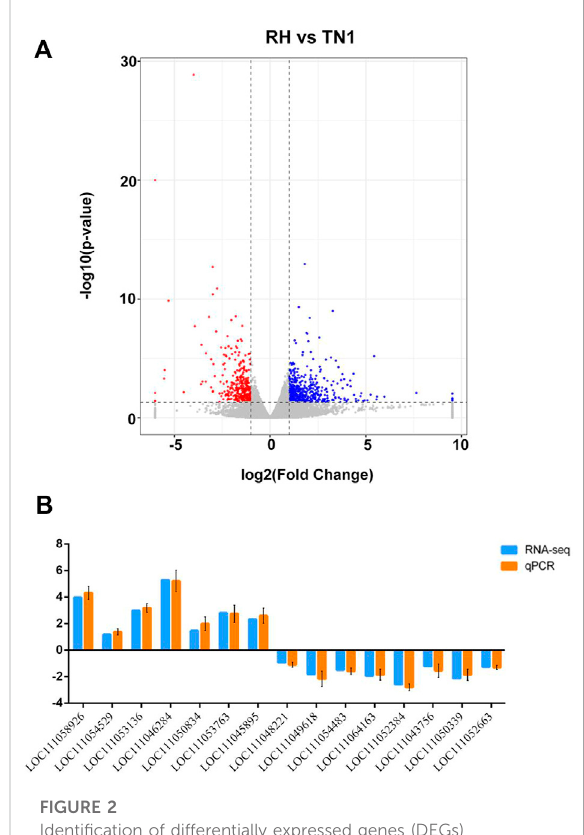
FIGURE 2 Identi fi cation of differentially expressed genes (DEGs) between BPH reared on RH and TN1 varieties. (A) Volcano plot for the expression pattern of each gene. Black, red, and blue points represent no difference in expression, upregulated genes, and downregulated genes, respectively. (B) Comparison of the transcriptome analysis and qRT-qPCR validation. LOC111058926, procollagen C-endopeptidase enhancer; LOC111054529, mitochondrial; LOC111053136, endocuticle structural glycoprotein; LOC111046284, insulin-like peptide; LOC111050834, uncharacterized protein; LOC111053763, acetylcholine receptor; LOC111045895, keratin-associated protein; LOC111048221, ATP-citrate synthase; LOC111049618, maltase;LOC111054483,sodiumchannelprotein;LOC111064163,